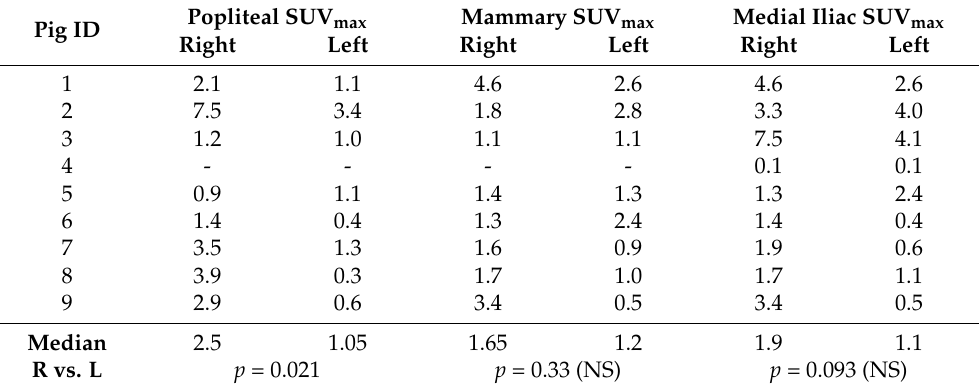
Table 4. Maximum Standardized Uptake Values (SUV max ) of [ 11 C]methionine in lymph nodes. Popliteal SUV Pig ID